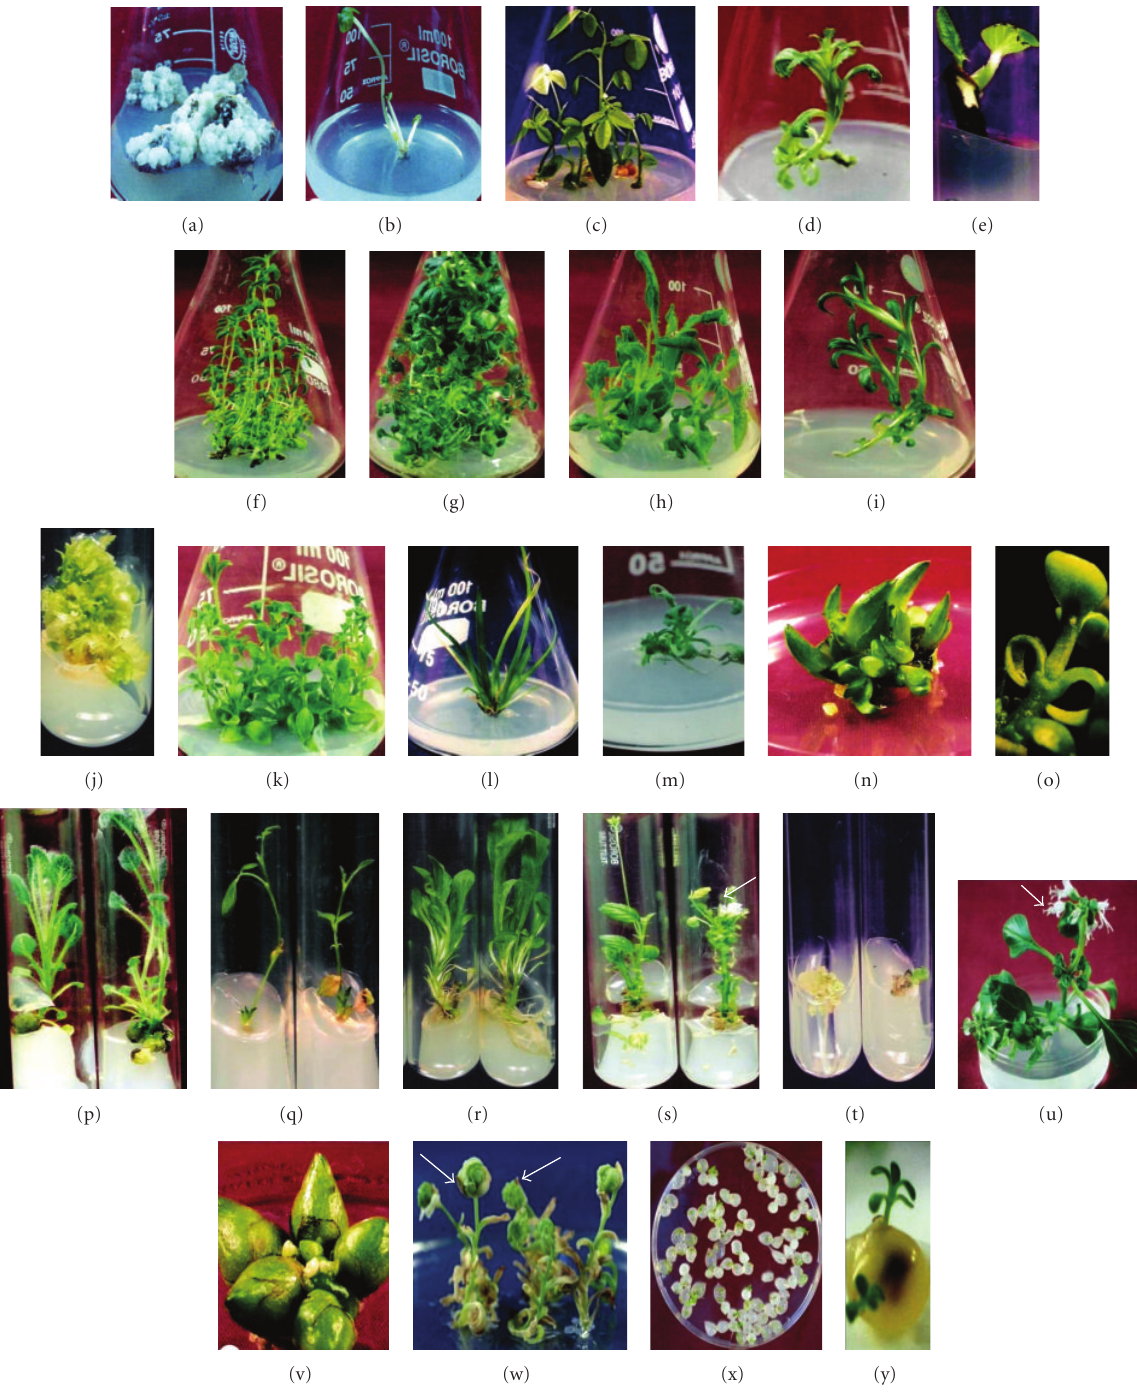
Figure 2: In vitro established cultures of 23 plant species. (a) Elaeocarpus spehericus , (b) Rheum emodii , (c) Indigofera tinctoria , (d) Picrorrhiza kurroa , (e) Bergenia ciliata , (f) Lavandula o ffi cinalis , (g) Valeriana wallichii , (h) Coleus forskohlii , (i) Gentiana kurroo , (j) Saussurea lappa , (k) Stevia rebaudiana , (l) Acorus calamus , (m) Pyrethrum cinerariefolium , (n) Aloe vera , (o) Bacopa moneeiri , (p) Salvia sclarea , (q) Glycyrrhiza glabra , (r) Swertia cordata , (s) Psoralea corylifolia , (t) Jurinea mollis , (u) Ocimum sanctum , (v) Paris polyphylla , (w) Papaver somniferum , and (x)-(y) synseeds of Bacopa moneeiri . Arrows showing in vitro